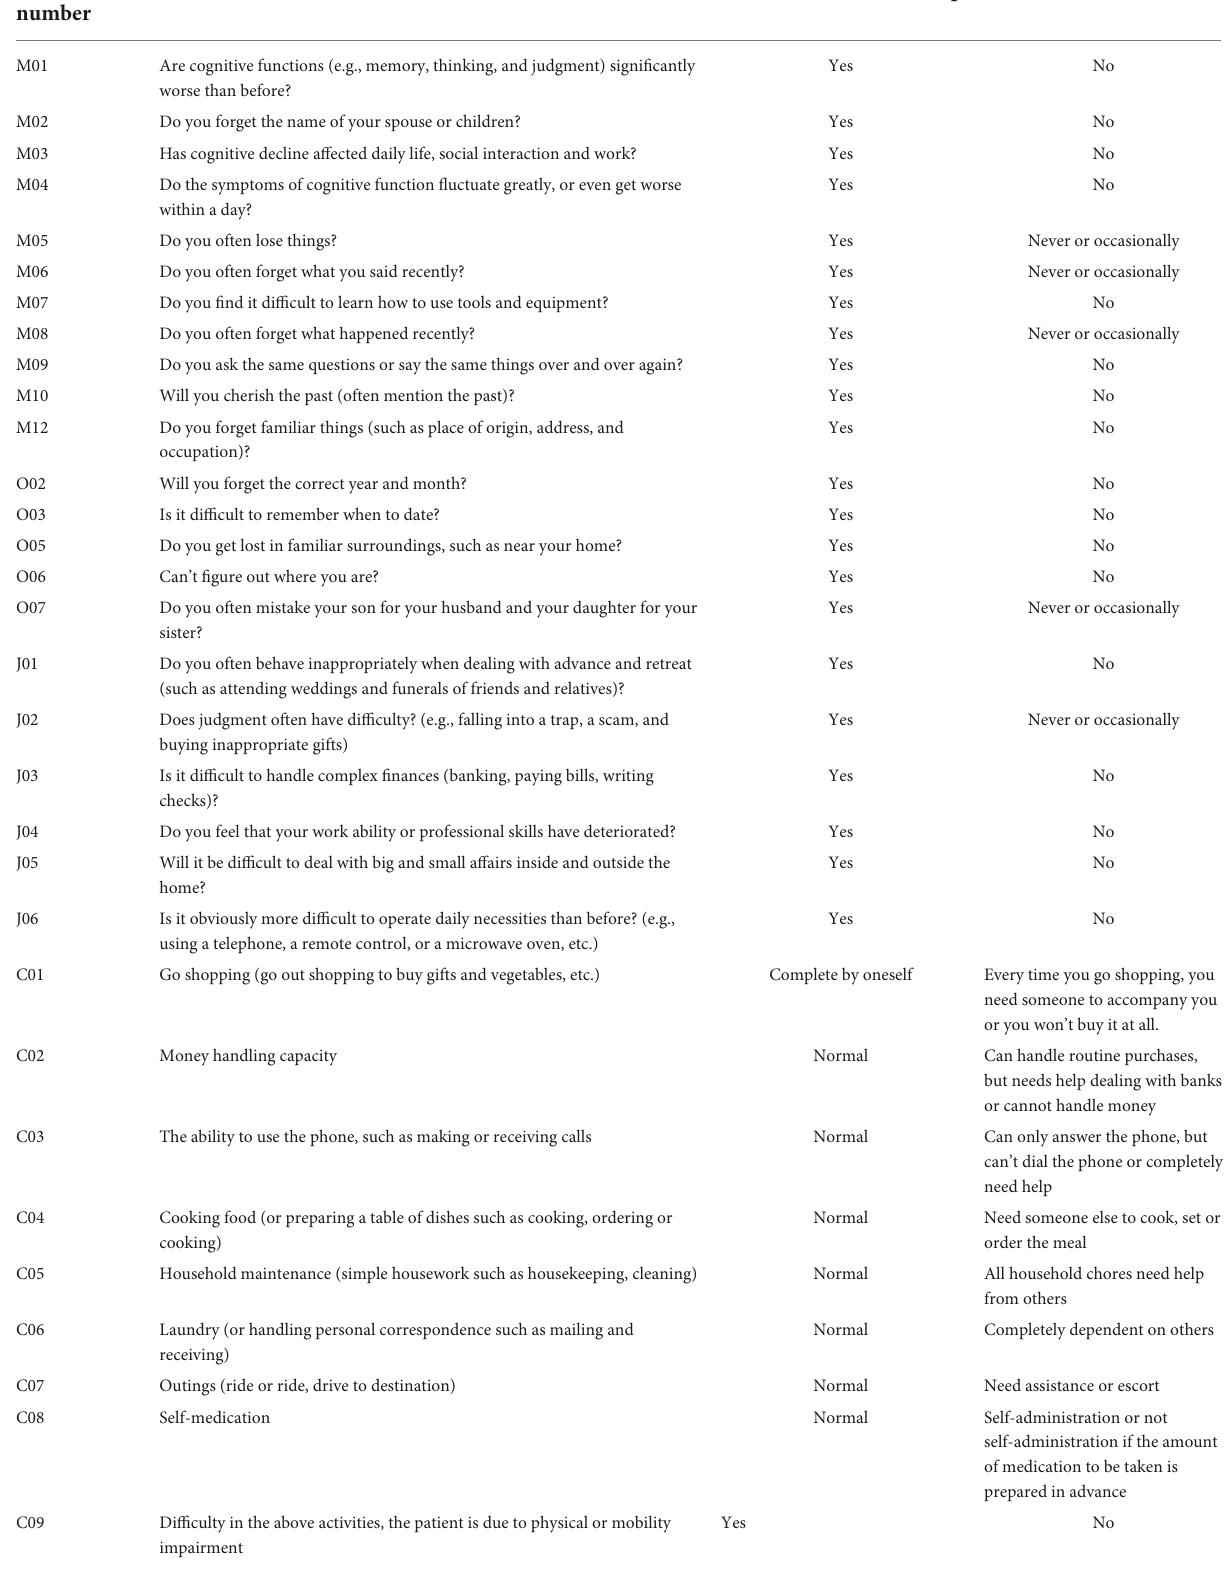
TABLE 1 Questions in the clinical dementia